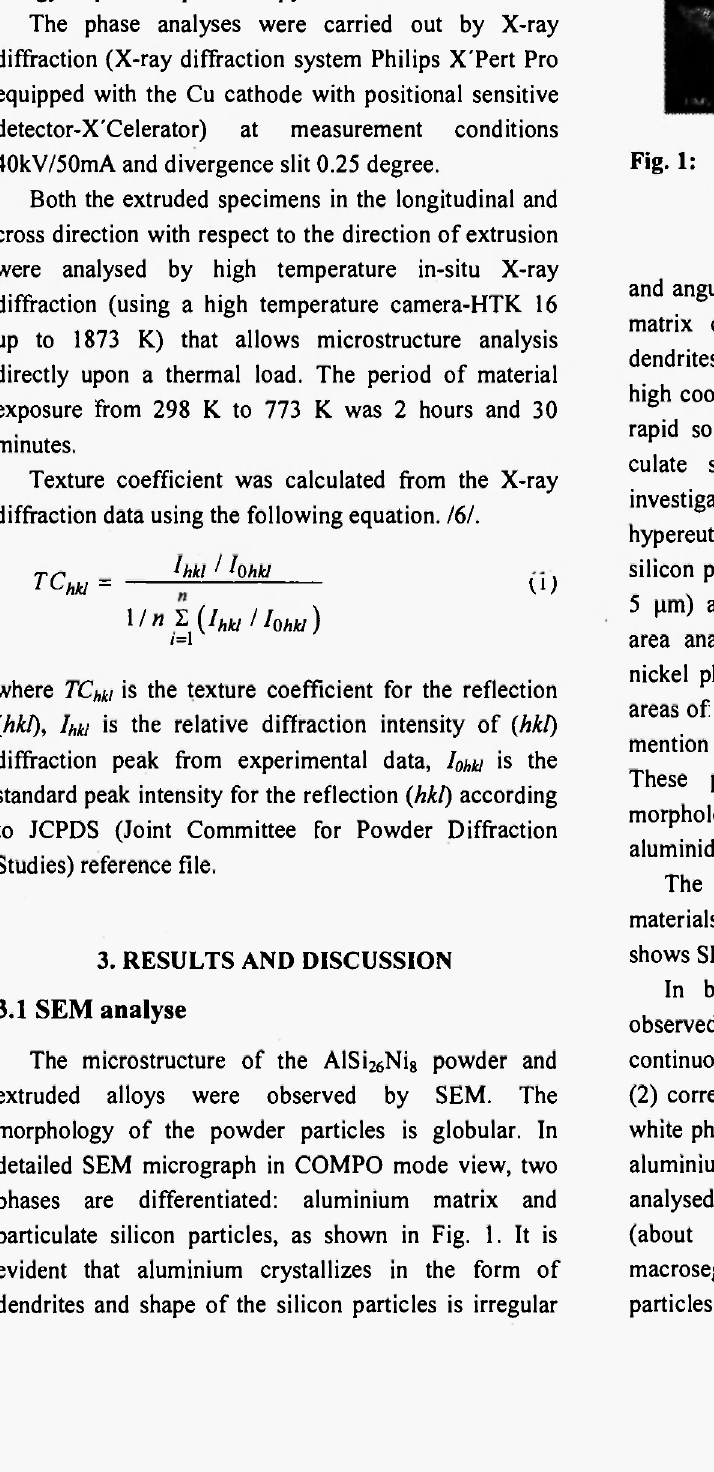
Fig. 1: Detailed SEM micrograph of the AlSi 2 6Ni 8 powder